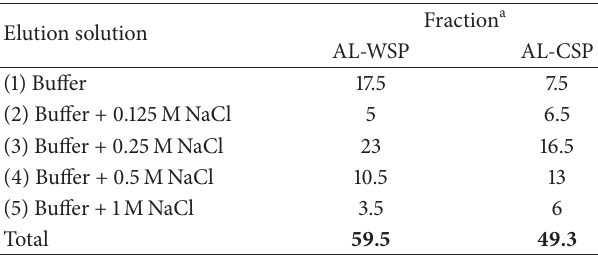
Table 2: Mass yield of water-soluble AL-WSP and chelating-soluble AL-CSP pectins obtained by ion exchange chromatography.